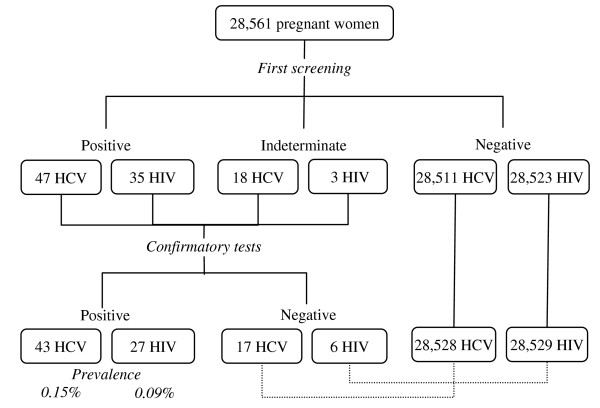
Screening for HCV and HIV infection among pregnant women in Public Health Settings, Central Brazil. Five out of 65 anti HCV-positive/indeterminate women and five out of 38 anti-HIV positive/indeterminate women could not be traced for confirmatory test. Doted lines indicate that indeterminate test results (HCV and HIV) were considered negative.